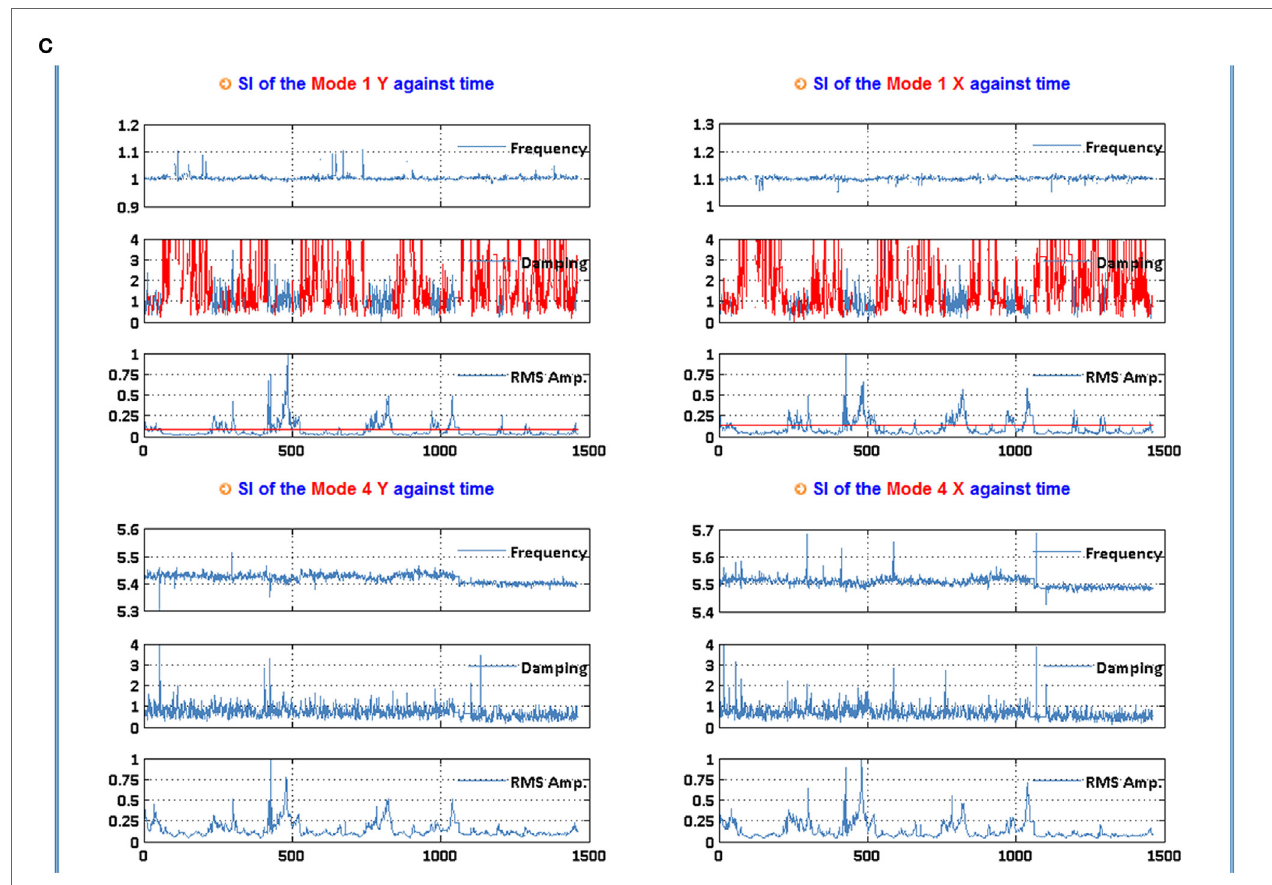
FigUre 15 | (a) Web-based automated NRT hybrid SI framework in Burj Khalifa. (B,c) Result web interface for normal